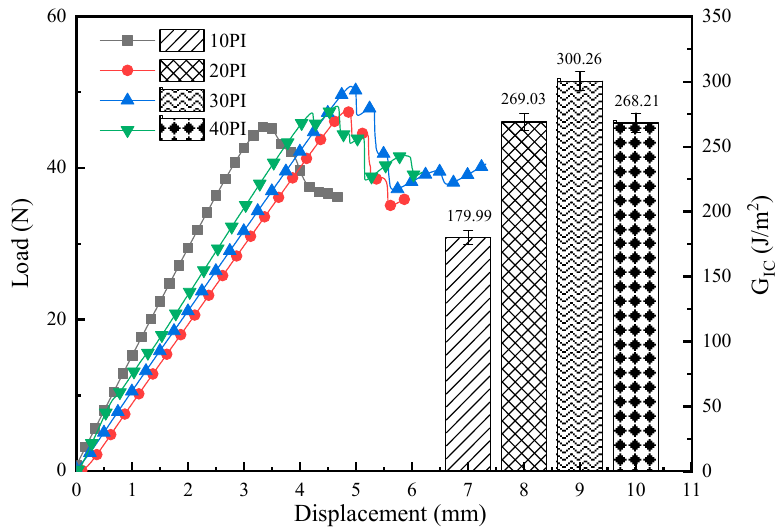
Figure 3. Load–displacement curves and mode I interlaminar fracture toughness for 10 PI-, 20 PI-, 30 PI-, and 40 PI-toughened composites.